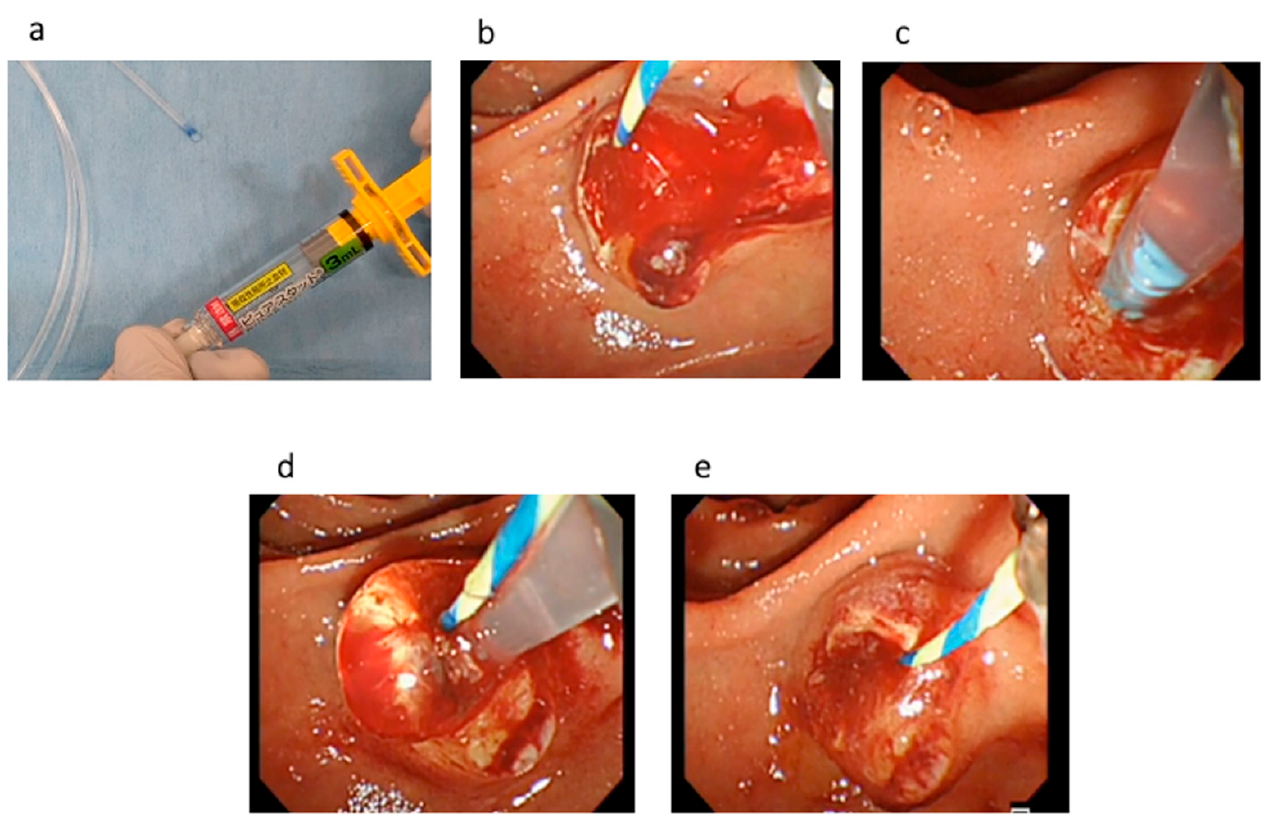
Figure 2. ( a ) The dedicated delivery catheter is filled with PuraStat at the top of the catheter. ( b ) EST bleeding is observed. ( c ) To prevent PuraStat dislocation into the third part of the duodenum, the duodenoscope is adjusted until the ampulla of Vater is at 3 to 6 o’clock on the endoscopic image. ( d ). PuraStat is subsequently applied. ( e ) Hemostasis is successfully obtained.